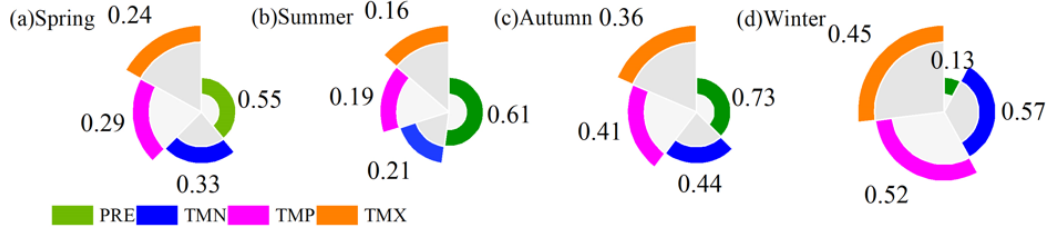
Figure 8. Contributions of climatic factors to the spatial distribution of seasonal SM in 2020, ( a ) spring: ( b ) summer, ( c ) autumn, and ( d ) winter, respectively.